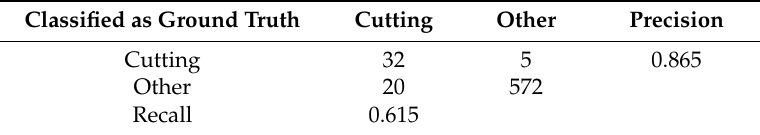
Table 9. Values for the optimal F ( F = 0.77, recall = 0.731, precision = 0.816).